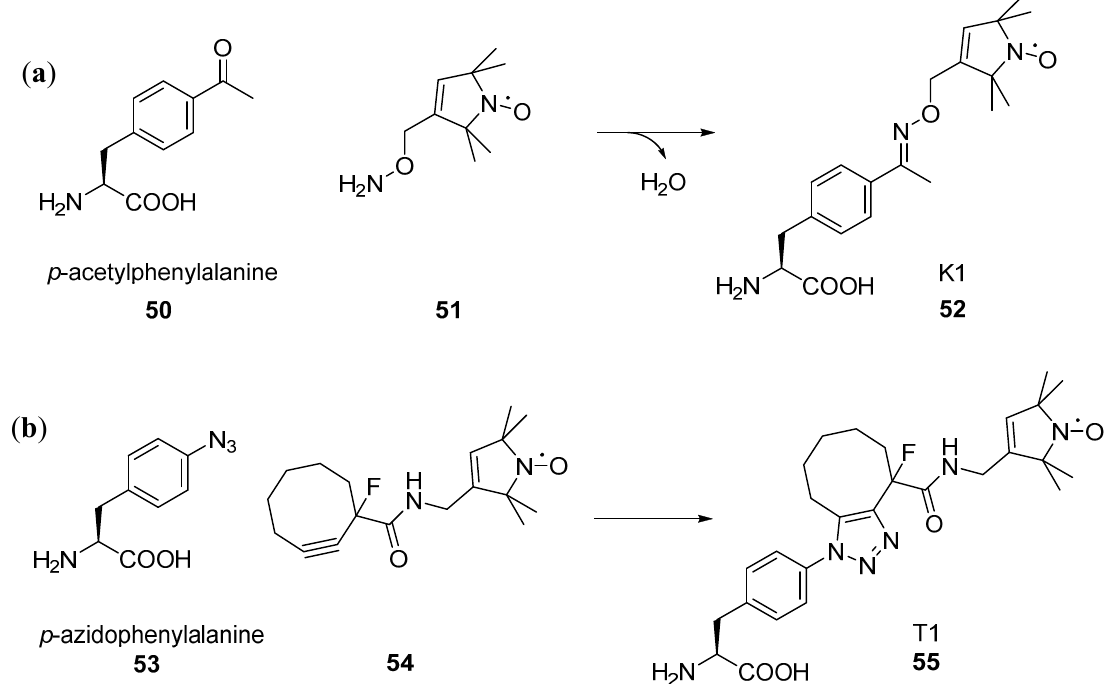
Figure 14. Spin labelling of unnatural amino acids ( a ) p -acetyl phenylalanine 52 and ( b ) p -azidophenylalanine 55